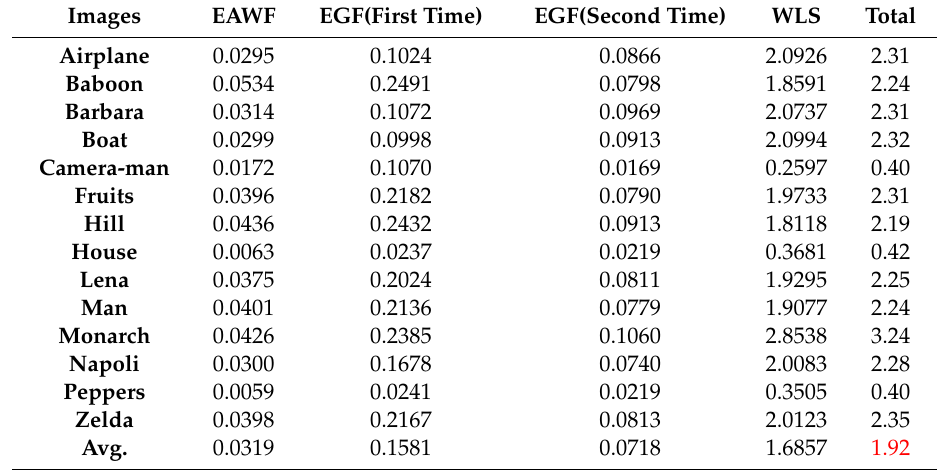
Table 12. The runtime of all the filters in the proposed method. (the second-best value is shown in red color.).